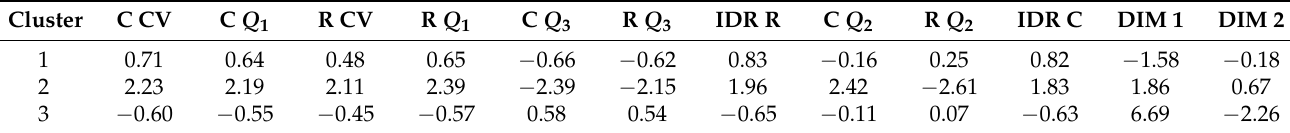
Table 2. Cluster centroids for each